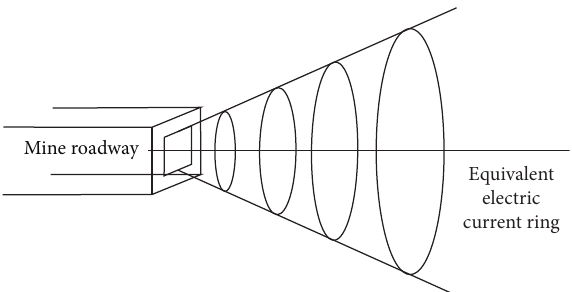
Figure 4: Schematic of transient electromagnetic process in detection of electromagnetic